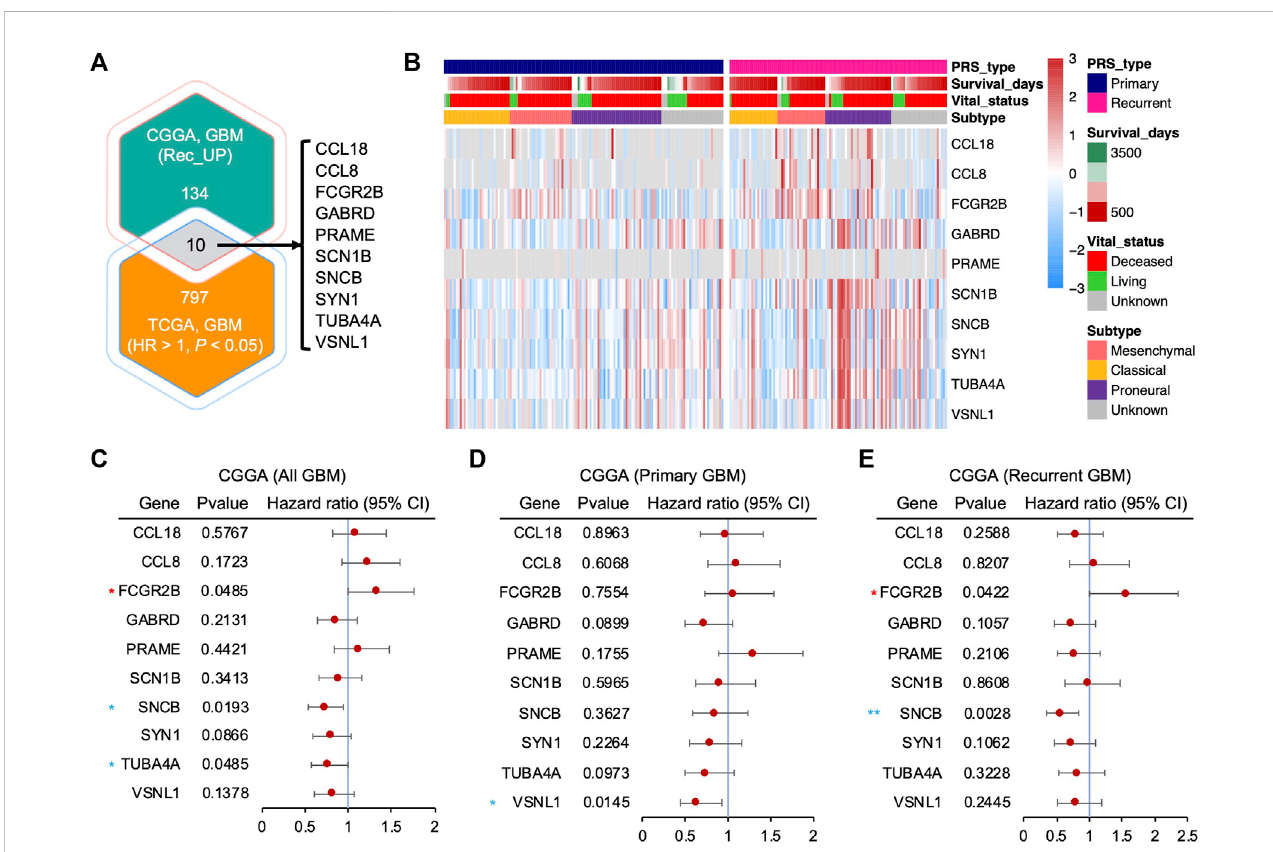
FIGURE 2 Identi fi cation of differentially expressed genes from recurrent GBM. (A) Venn diagram showing the intersected gene list between the upregulated genes in recurrent GBM from the CGGA cohort and potential oncogenes from The Cancer Genome Atlas (TCGA) cohort (hazard ratio (HR) > 1 and p < 0.05). (B) Heatmap depicting the mRNA expression of thepotential oncogenic regulator candidates in (A) fromthe CGGA cohort. (C – E) Forest plots showingtheHR of the upregulated genes in all GBMs, including both primary and recurrent GBM (C) , primary GBM (D) , and recurrent GBM (E) , from the CCGA cohort throughunivariateCoxregressionanalysis.Horizontallinesrepresent95%con fi denceintervals(CI)ofHR.Redasterisk,HR > 1and p < 0.05;blueasterisk,HR < 1 and p < 0.05. * p < 0.05, ** p <